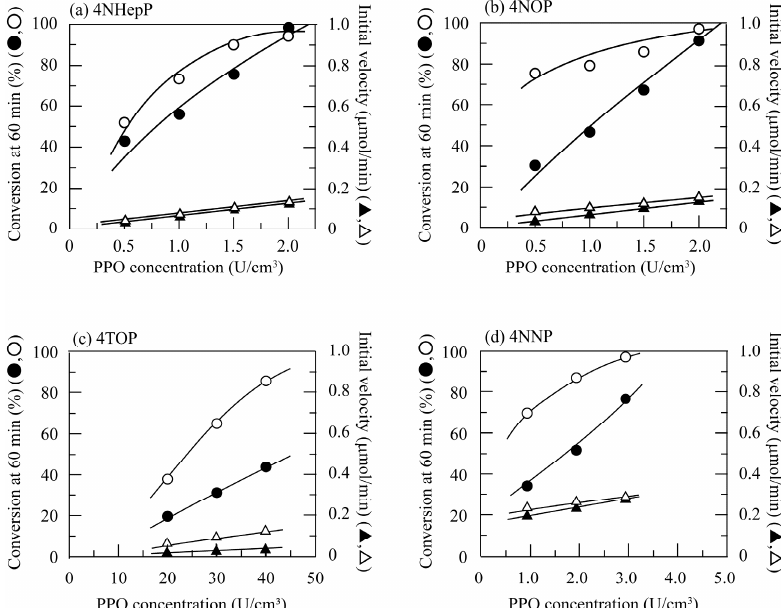
Figure 3. Changes in the conversion percent value at 60 min (circle) and the initial velocity (triangle) with the PPO concentration for PPO-catalyzed quinone oxidation of ( a ) 4NHepP, ( b ) 4NOP, ( c ) 4TOP, and ( d ) 4NNP at pH 7.0 and 40 °C in the presence (open) or absence (shaded) of chitosan beads at 0.10 cm 3 /cm 3 .